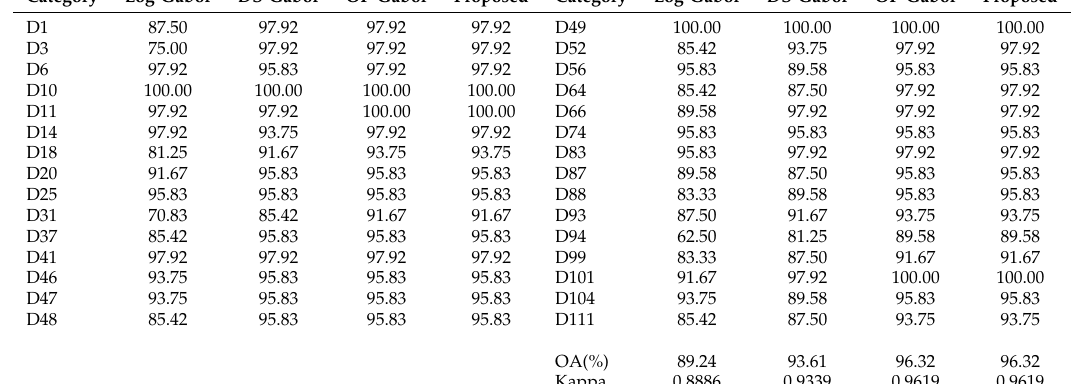
Table 5. Overall classification accuracy and Kappa coefficient for Brodatz database.